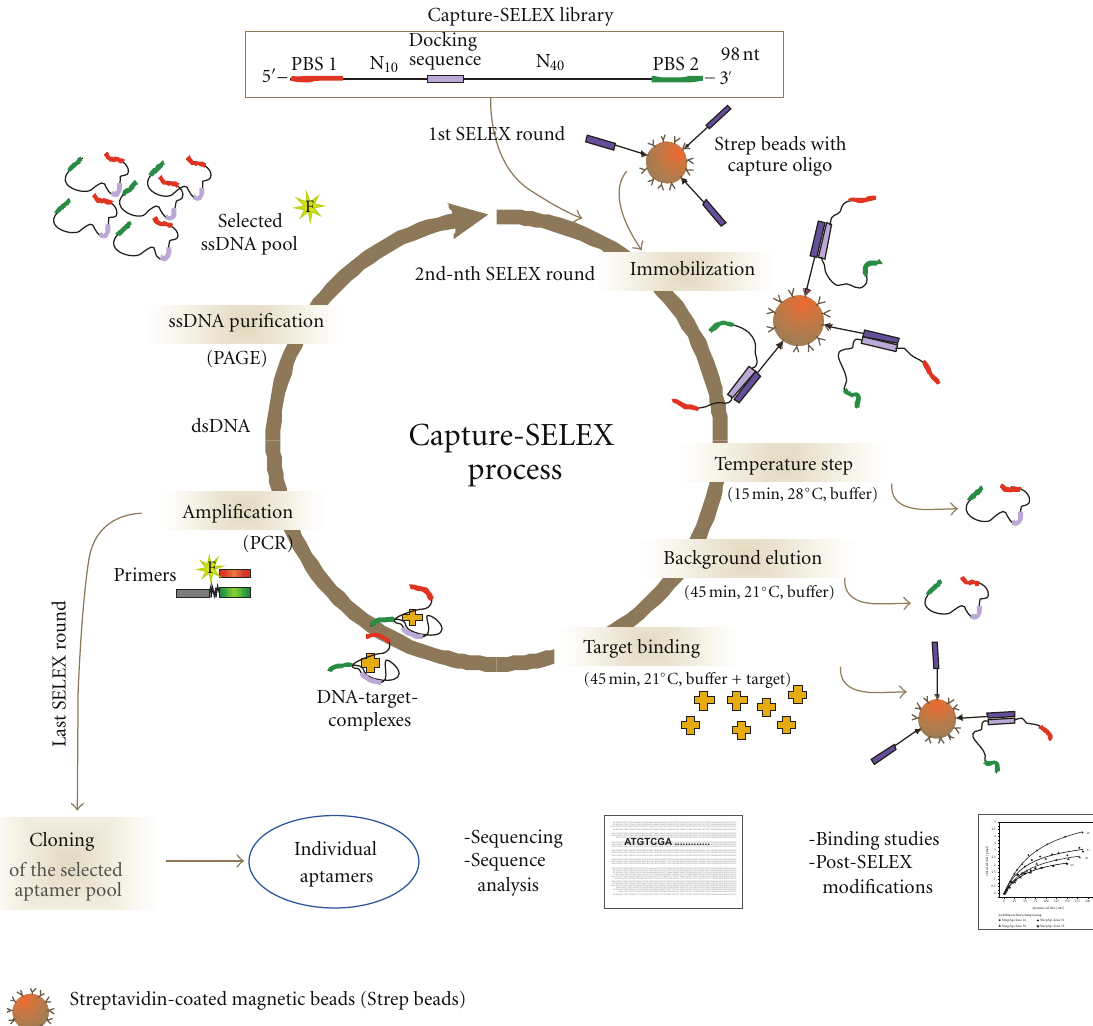
Figure 2: Capture-SELEX